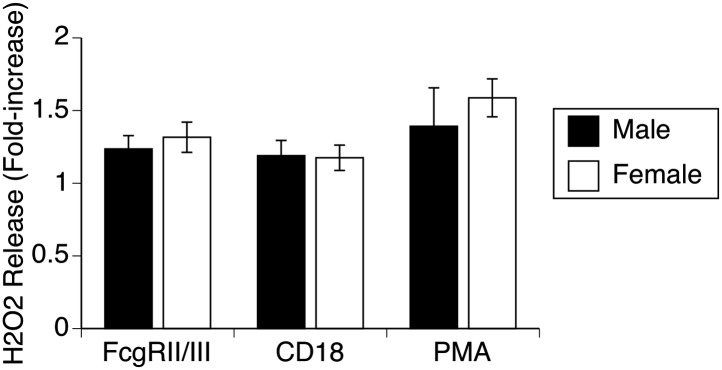
Respiratory burst by male and female alveolar macrophages.Stimulation of normal AMs by antibodies to 2 different surface receptors (FcR, CD18) or with PMA leads to approximately equal increases in H2O2 release in both male and female AMs, indicating absence of gender differences in production of reactive oxygen species.